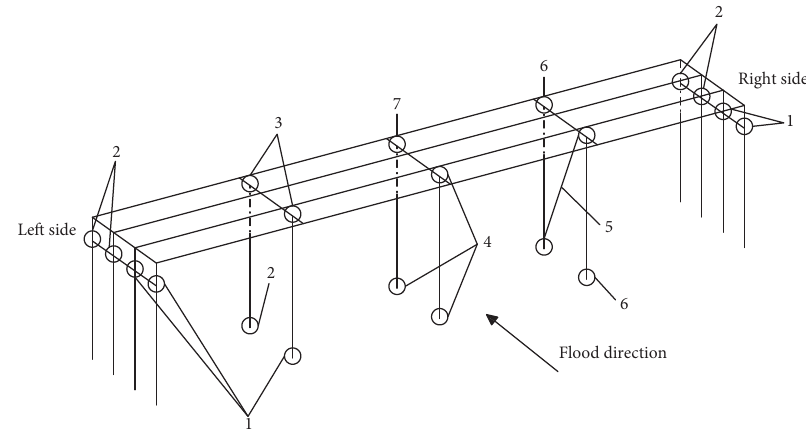
Figure 31: The order of occurrence of plastic hinges. Table 20: Base shears at piers corresponding to occurrence sequence of plastic